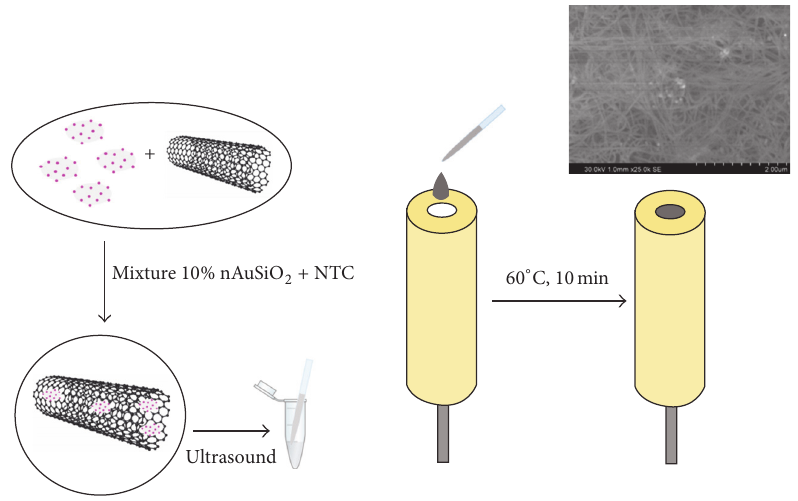
Scheme 1: Schematic preparation of the modified electrode. Inset SEM image of CNT/nanoAu-SiO 2